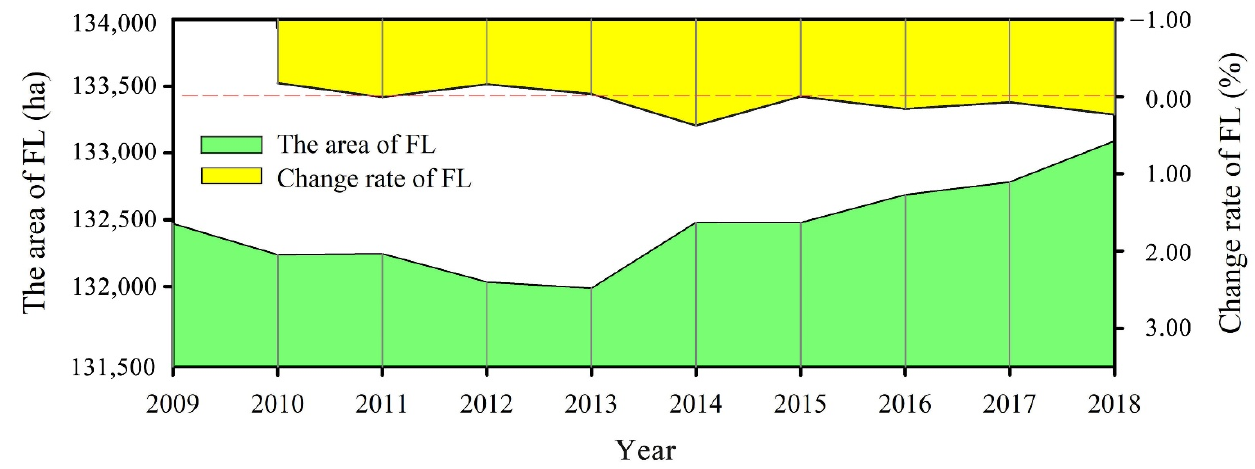
Figure 2. Changes in the area of farmland (FL) in Sihong from 2009 to 2018.